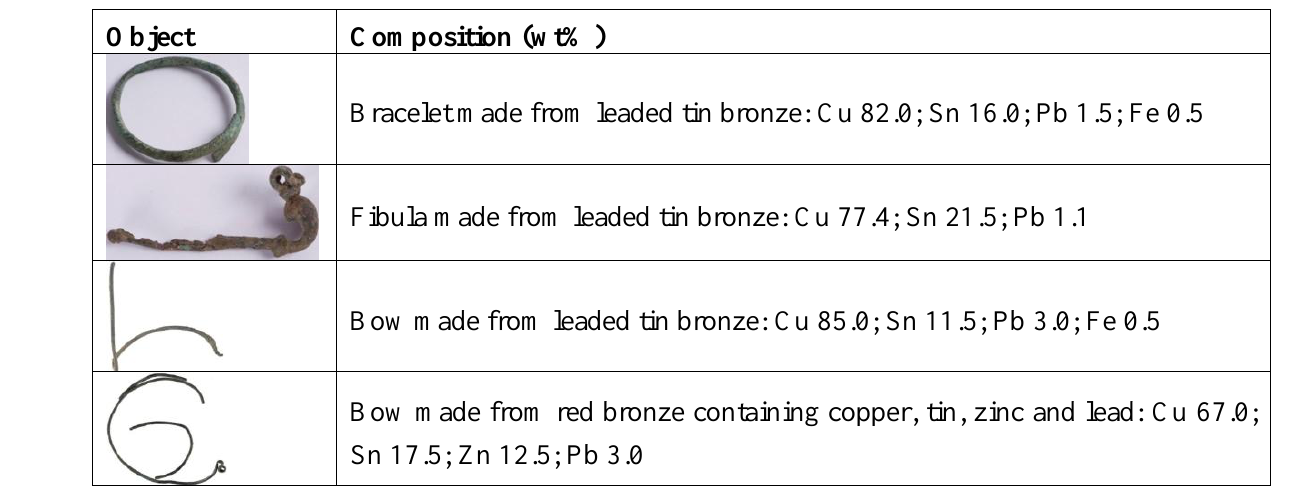
Table 3. Results of LIBS measurements of the original substrate alloy composition of four archaeological objects selected for the studies presented